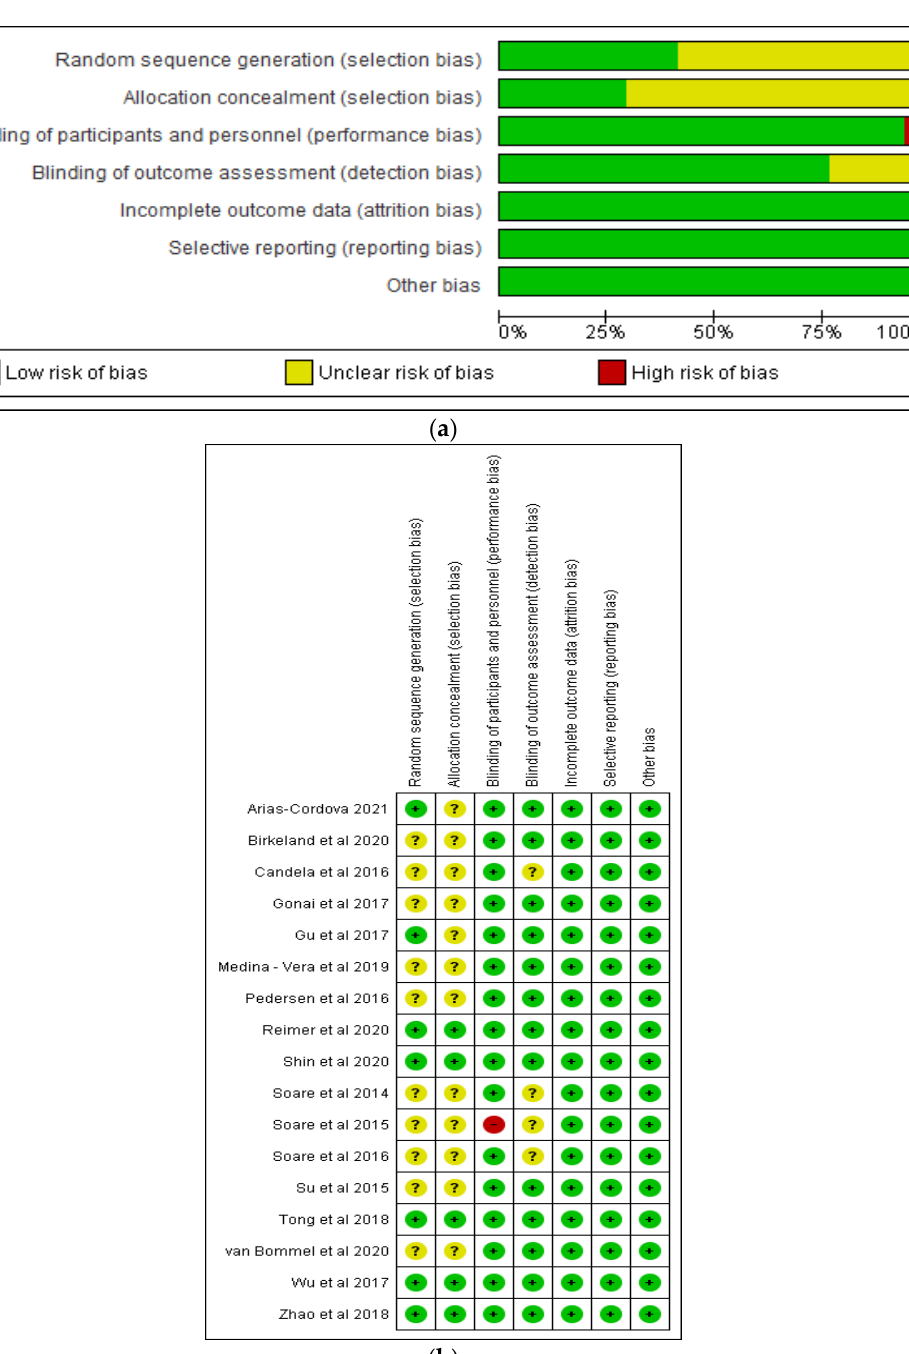
Figure 2. Graphs showing ( a ) risk of bias ( b ) risk of bias summary [18,31,32,36–46].